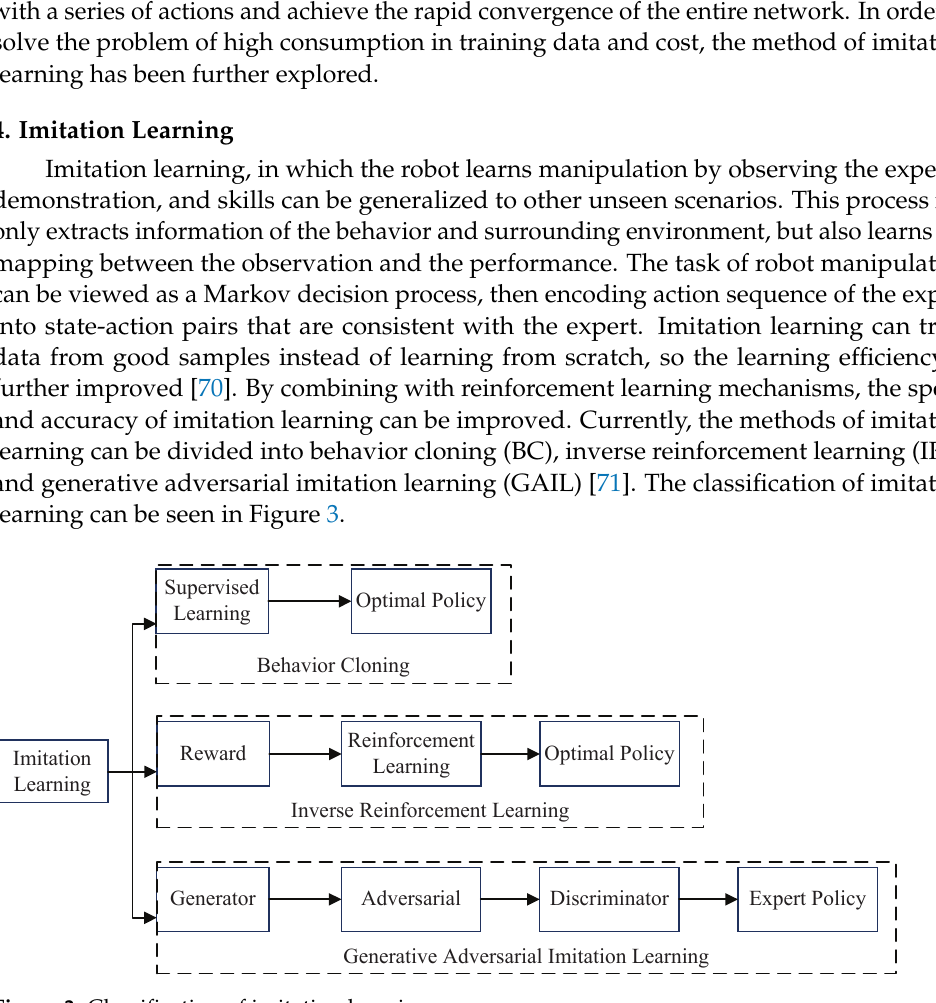
Figure 3. Classification of imitation